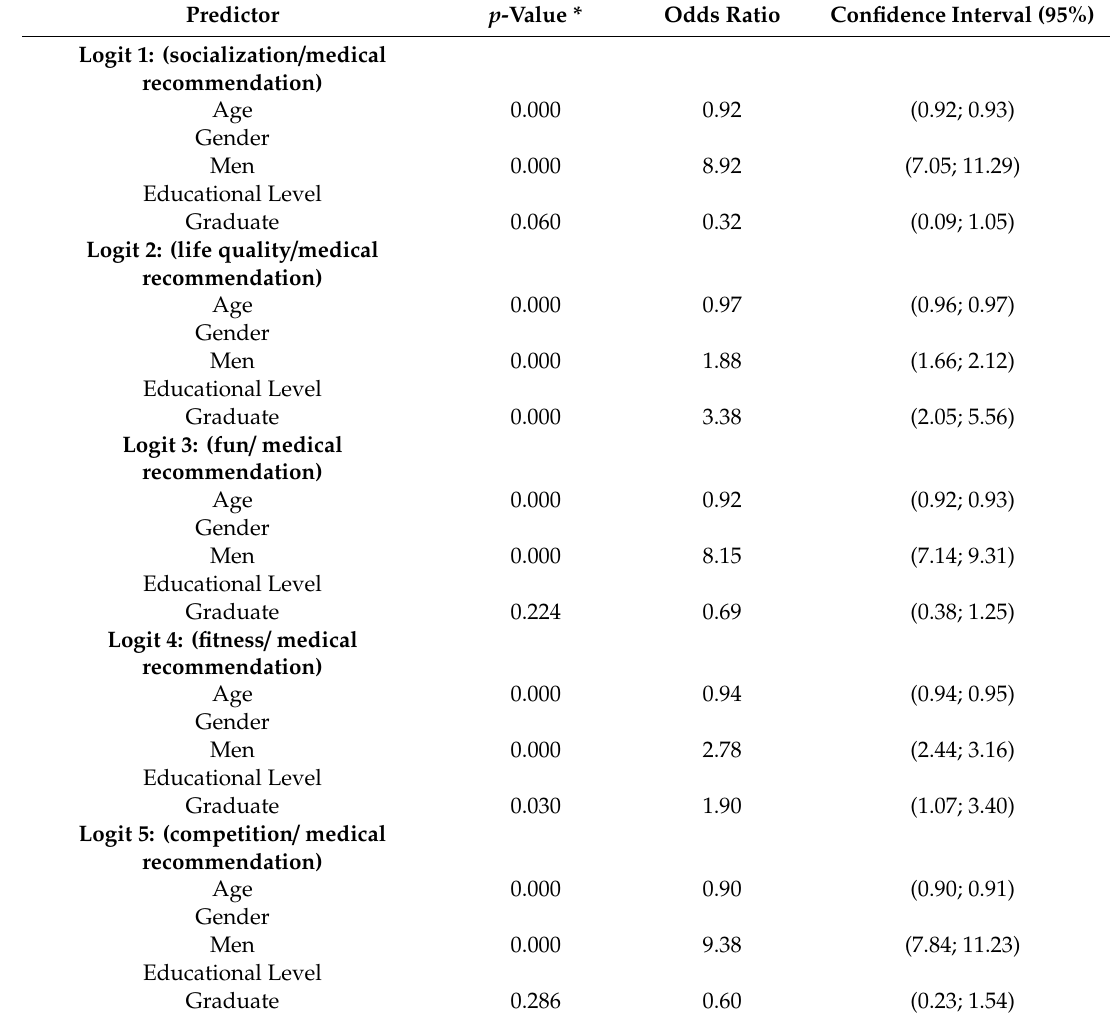
Table 4. Main results of the nominal logistic regression—motives for practicing